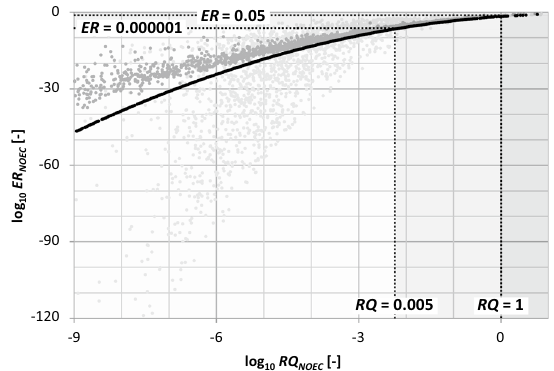
Fig. 8 Expected risk ER versus risk quotients RQ of 1977 mono-constituent organic REACH chemicals. Light gray symbols: RQ calculated as in REACH (from untransformed concentration data); dark gray symbols: RQ calculated alternatively (from z-transformed concentration data), with σ PEC of all chemicals set to 0.3; black symbols: RQ calculated alternatively (from z-transformed concentration data), with all σ PEC set to